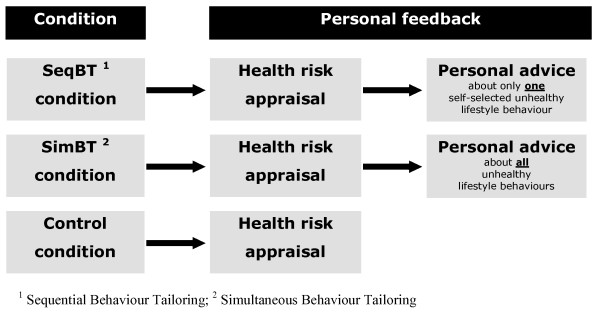
Design at baseline